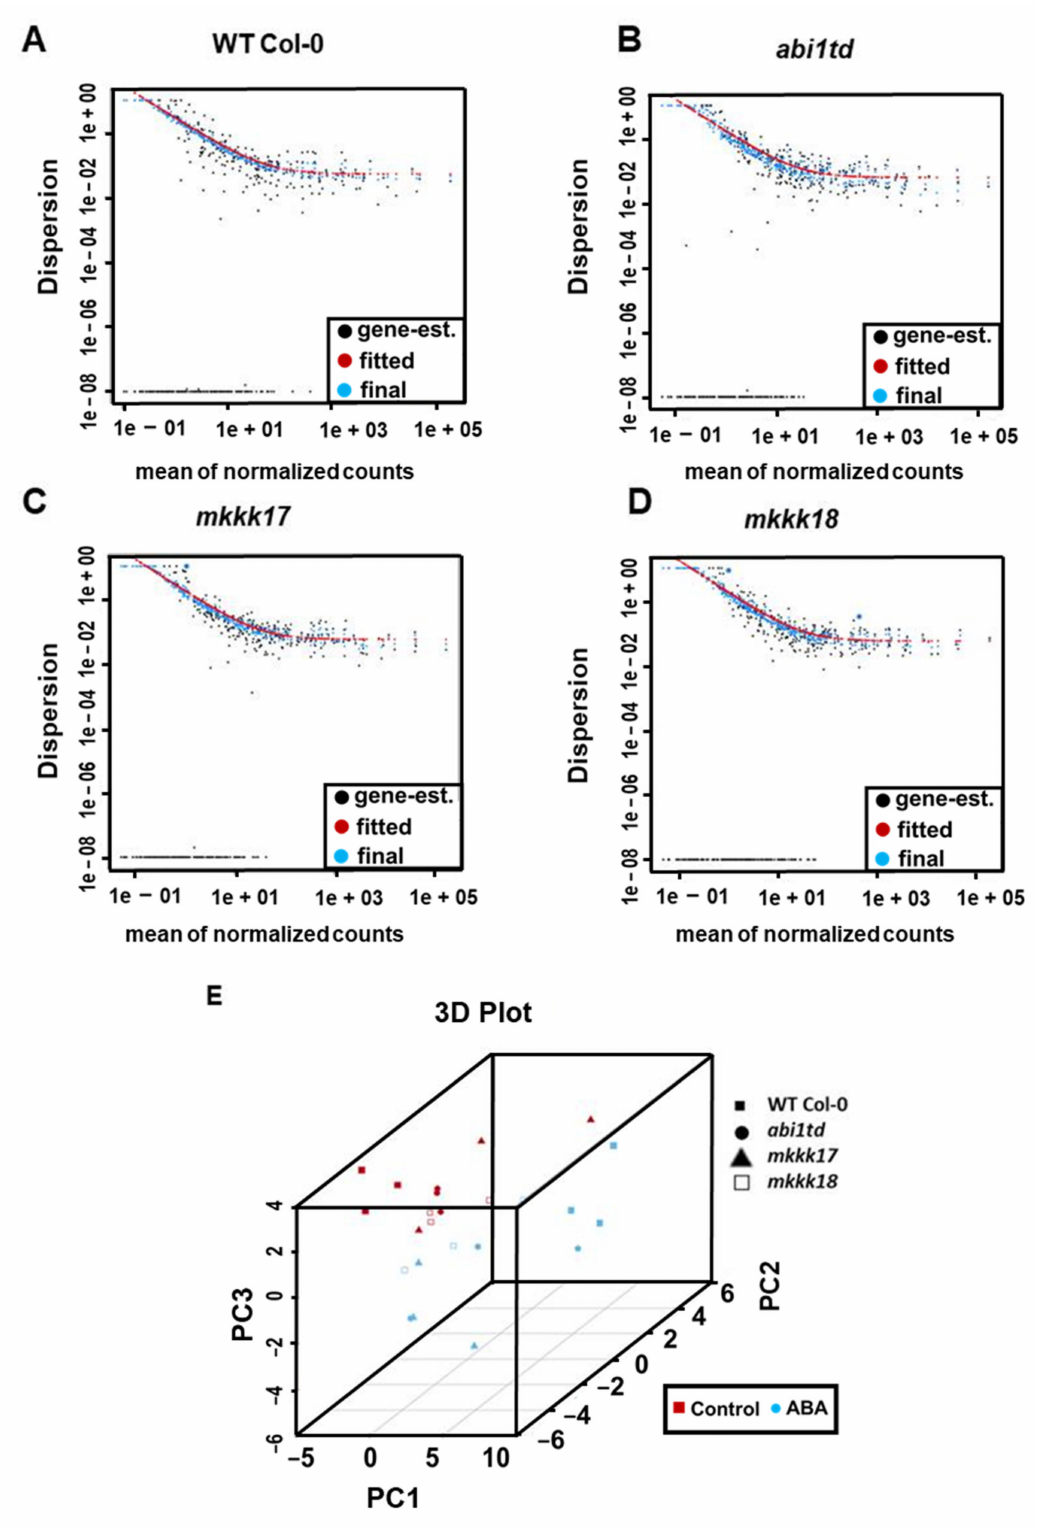
Figure 5. ABA-responsive small RNA clusters. Dispersion plot shows how the dispersion (variance) estimates are shrunk from the gene-wise values (black dots) toward the fitted estimates in ( A ) WT Col-0, ( B ) abi1td , ( C ) mkkk17 , and ( D ) mkkk18 mutants after ABA induction. Values in blue are the final values used in testing. ( E ) A three-dimensional PCA plot of small RNA-Seq libraries with or without ABA induction of all genotypes of Arabidopsis WT Col-0, abi1td , mkkk17 , and mkkk18